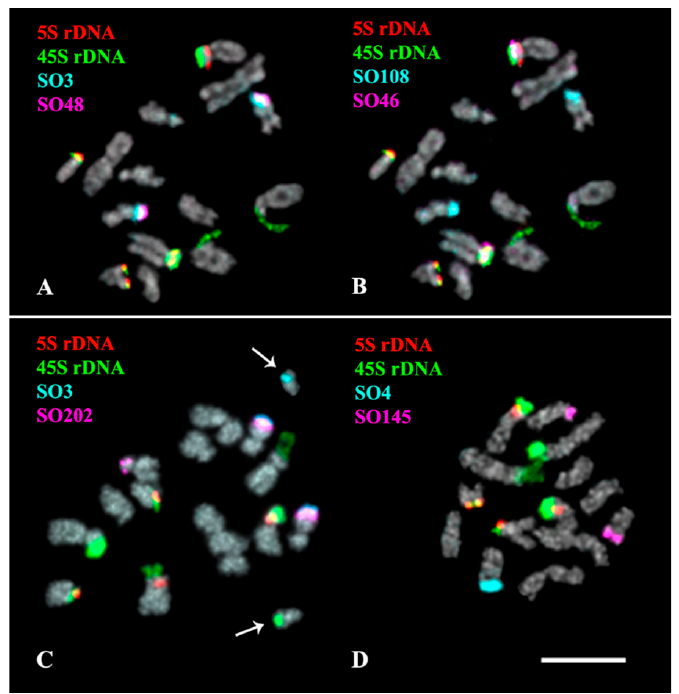
Figure 3. Localization of 45S rDNA, 5S rDNA, and oligonucleotide-based probes SO3 and SO48 ( A ), SO108 and SO46 ( B ), SO202 and SO3 ( C ), and also SO4 and SO145 ( D ) on chromosomes of Salvia officinalis . Merged fluorescent images after multicolor FISH with different combinations of the probes. Probe colors are shown on the left. Chromosome DAPI-staining—grey. Arrows indicate B chromosomes. Scale bar—5 μ m.